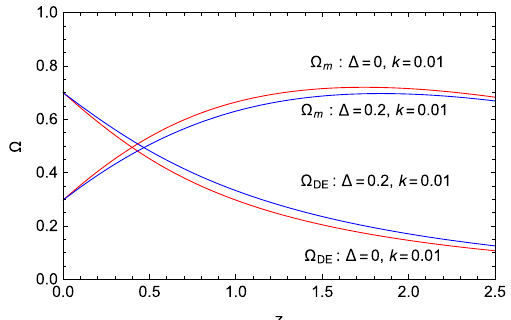
Fig. 4 Evolution deacceleration parameter, as a function of redshift z , for Δ = 0 . 2 and C = 3 , in unit of M 2 p = 1 . The line corresponds: red: k = 0 . 001 ; blue: k = 0 . 01 ; green: k = 0 . 05 ; magenta: k = 0 . 1